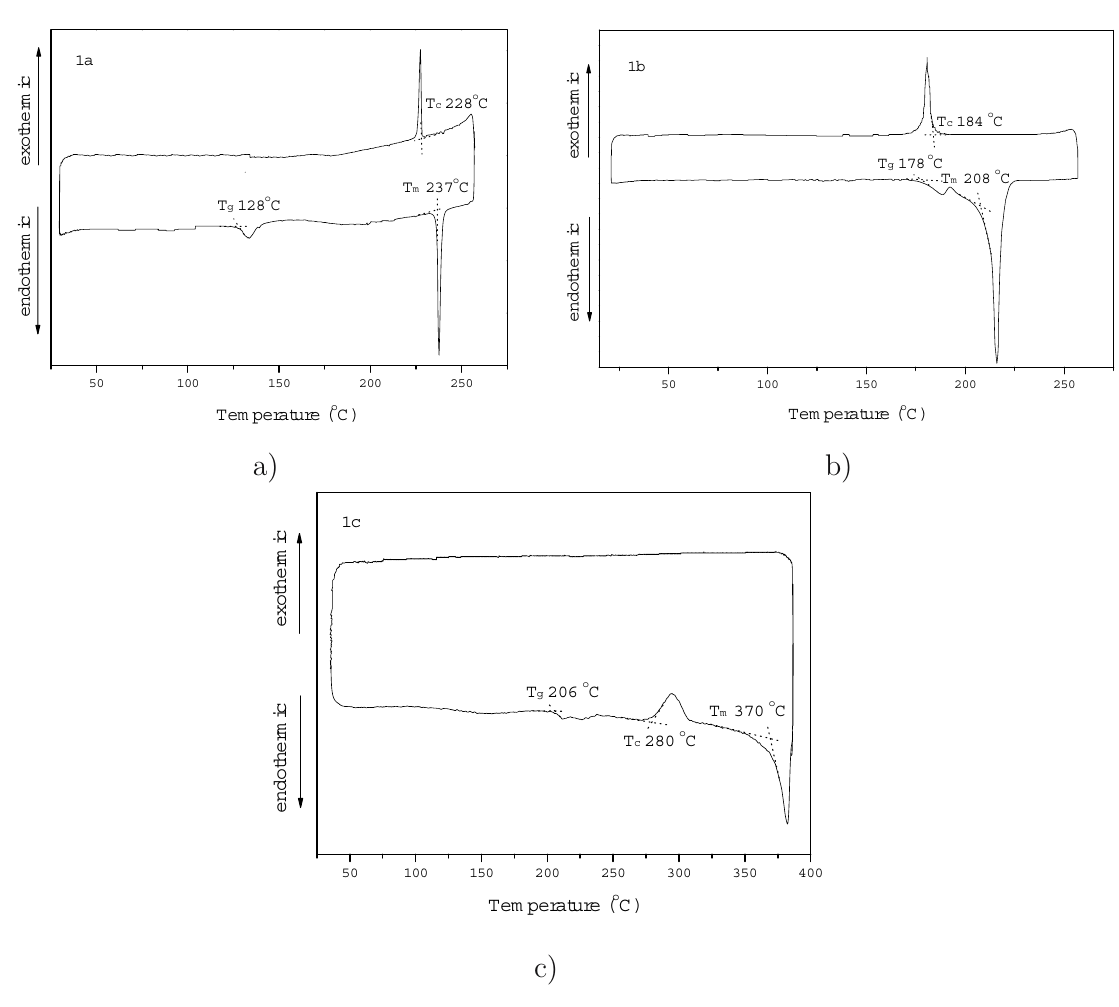
Fig. 1 DSC curves of 1a (a) , 1b (b) and 1c